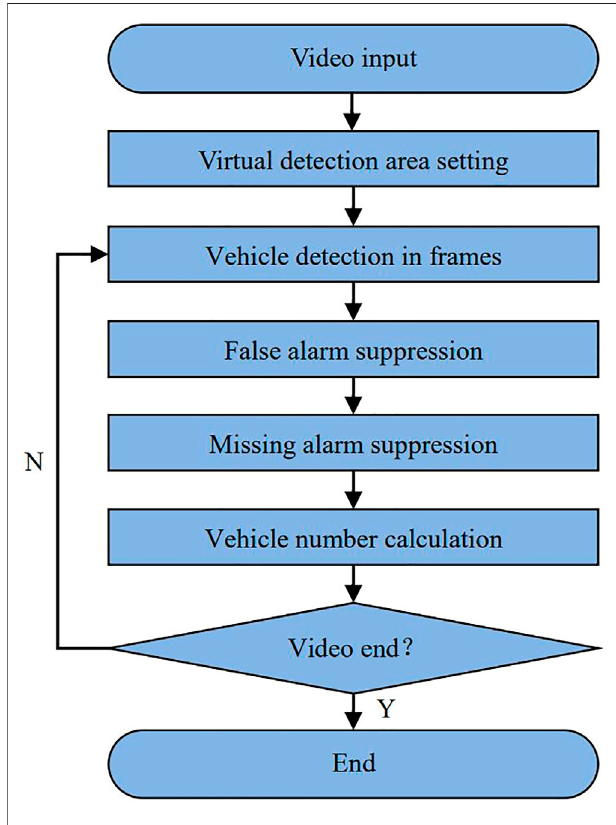
FIGURE 6 | The work fl ow of vehicle